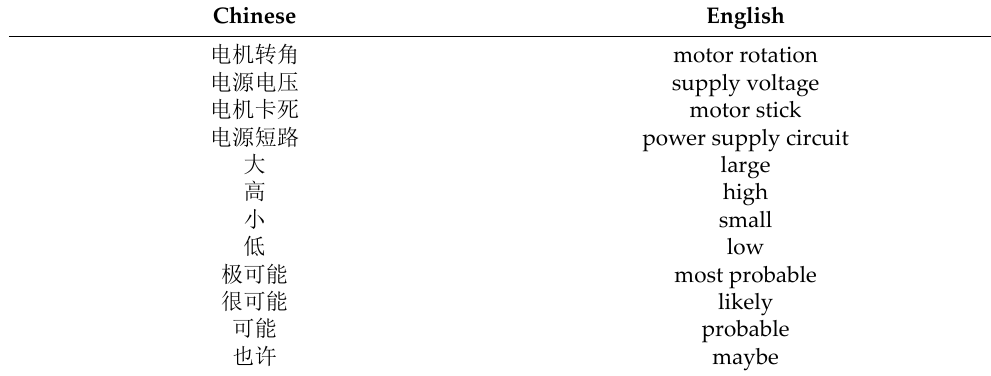
Table 1. The meaning of Chinese